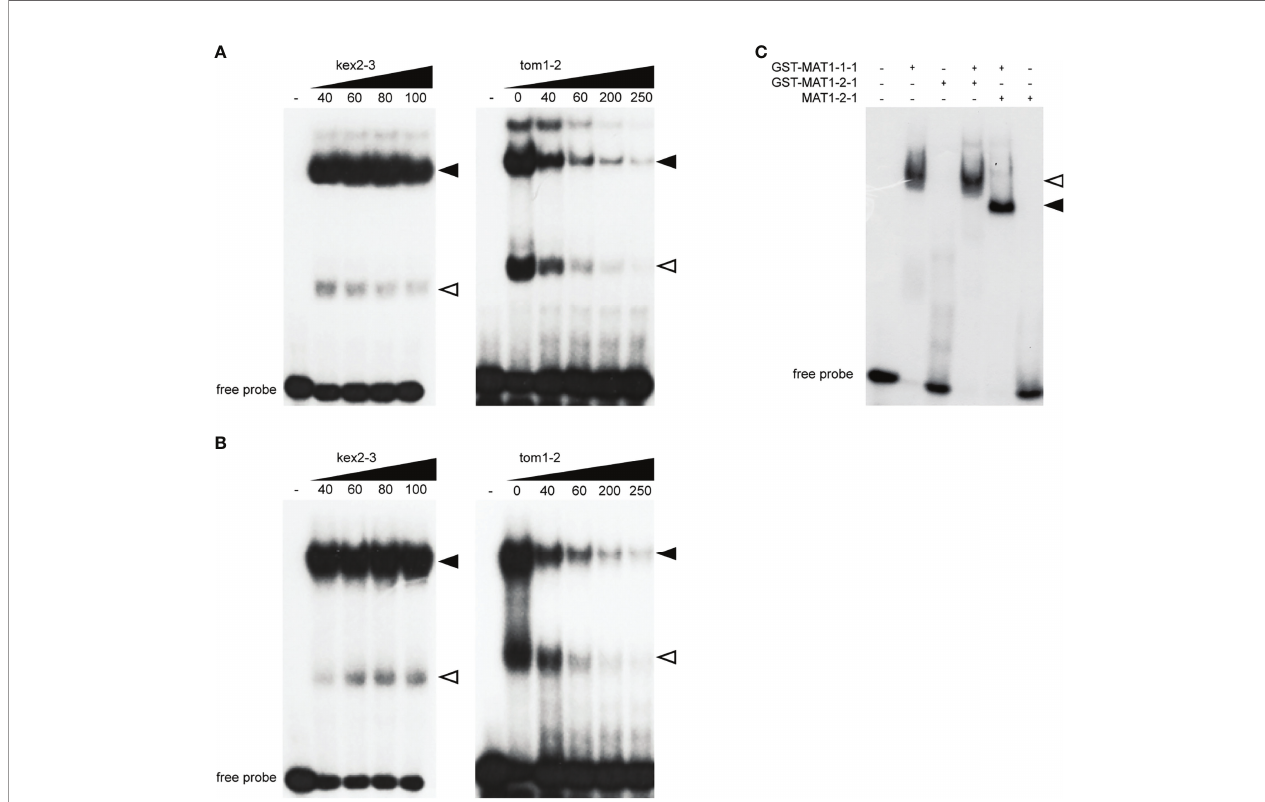
FIGURE 2 | EMSAs show sequence-speci fi c binding of the MAT1-1-1 and MAT1-2-1 proteins to the tom1-2. (A) EMSA image showing in vitro binding of GST- MAT1-1-1 to tom1-2 probe in presence of increasing competitor, nonspeci fi c kex2-3 (left) and speci fi c tom1-2 (right). Equal molar amounts (2.5 µM) of protein was mixed with unlabled competitor DNA in pmol, as indicated. (B) EMSA image showing in vitro binding of GST-MAT1-2-1 to tom1-2 probe in presence of nonspeci fi c kex2-3 (left) and speci fi c tom1-2 (right) competitor probe. Equal molar amounts (7 µM) protein was mixed with unlabled competitor DNA in pmol, as indicated. In (A, B) homodimers and heterodimers of GST-MAT1-1-1 in complex with tom1-2 are indicated by open and black arrowheads respectively. (C) EMSA showing cooperative binding of MAT1-1-1 and MAT1-2-1 to the tom1-2 derived from the promoter of the tom1 gene. Equal molar amounts (4 µM) of each protein were co- incubated with tom1-2 and applied to the gel. The arrowheads indicate formation of GST-MAT1-1-1/GST-MAT1-2-1/tom1-2 (open arrowhead) and GST-MAT1-1-1/ MAT1-2-1/tom1-2 (black arrowhead)